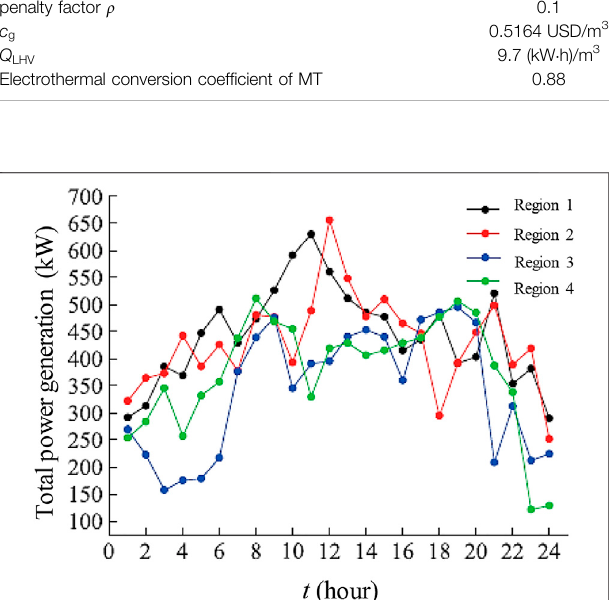
FIGURE 6 | Comparison of total generated power of each region.